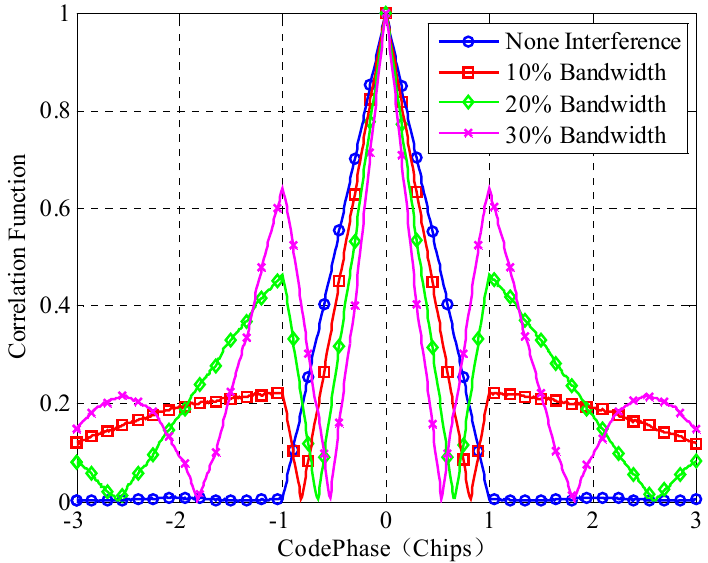
Figure 8. Influence of correlation function under different interference bandwidths.